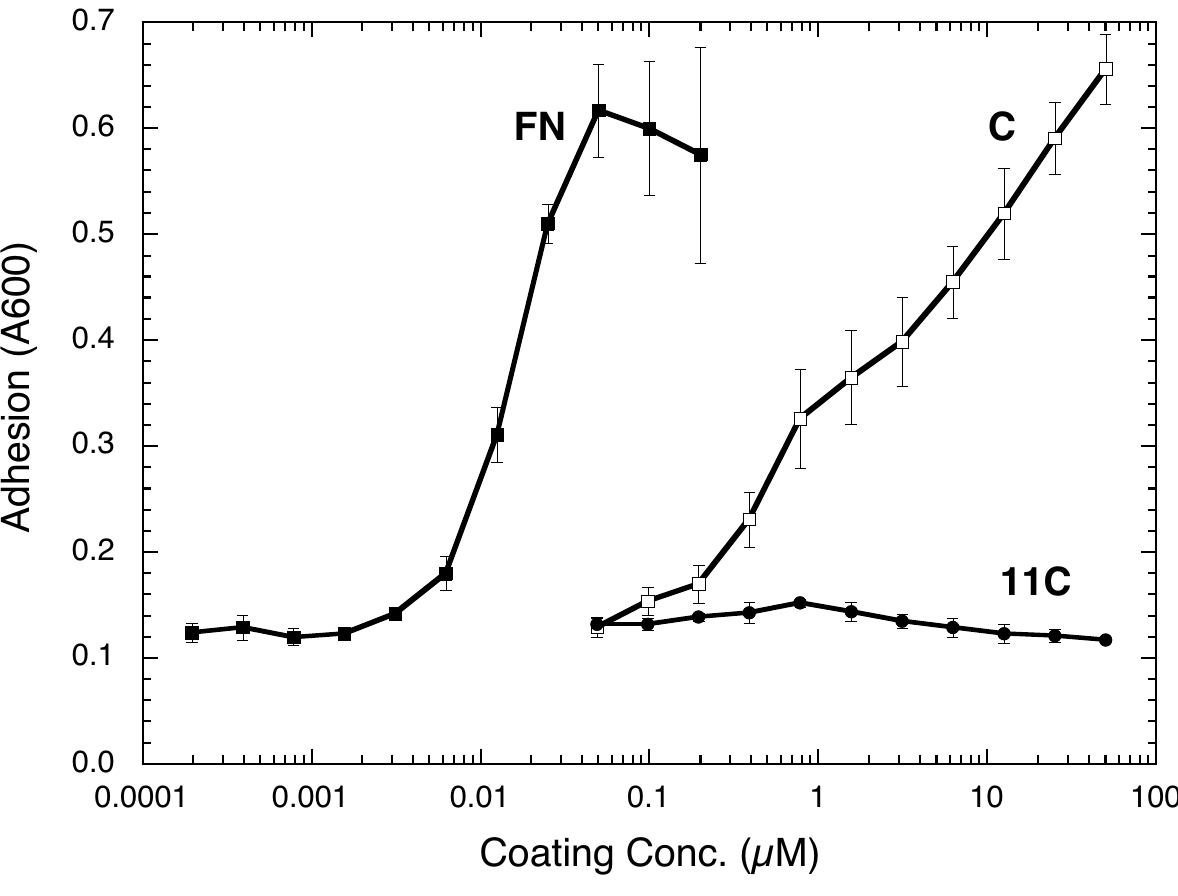
Figure 2 Cell attachment to III1-C. Fibronectin ( (cid:1) ), III1-C ( (cid:2) ) or III 11-C ( (cid:3) ) at various concentrations were coated onto plastic wells. RASMCs were seeded onto the coated wells and the cells were allowed to adhere for 30 min at 37 ° C. The cells were fixed, stained and the amount of cell attachment was measured. Each sample was performed in triplicate and the experiment was done three times with comparable results each